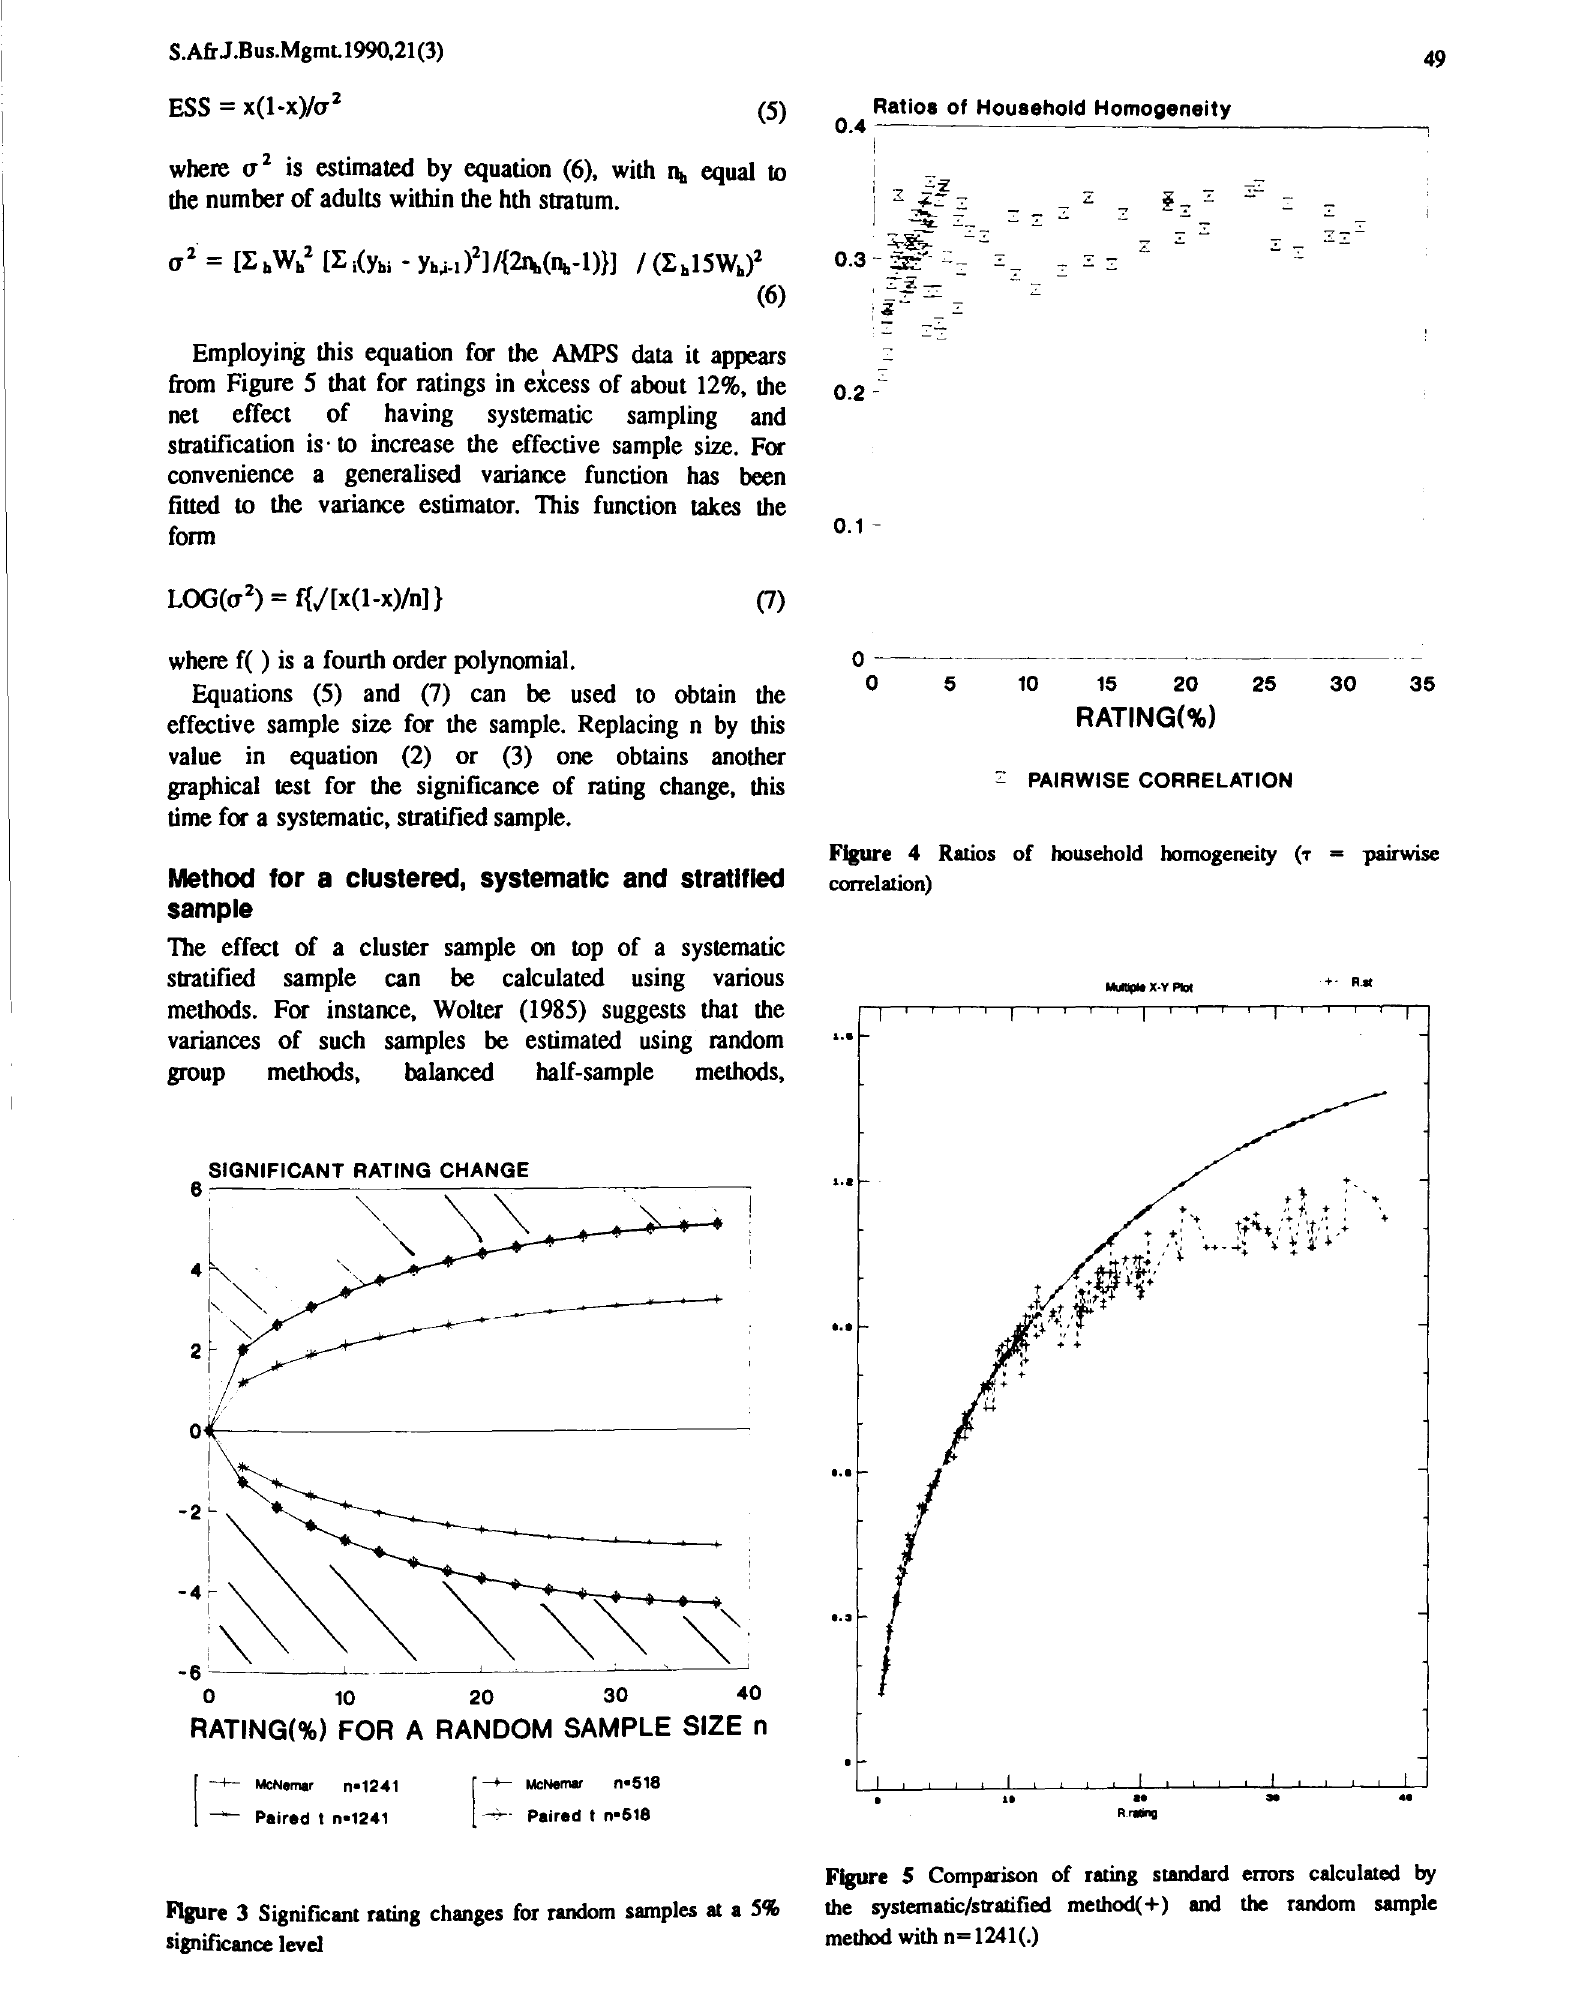
Figure S Comparison of rating standard errors calculated by the systematic/stratified method(+) and the random sample method with n=